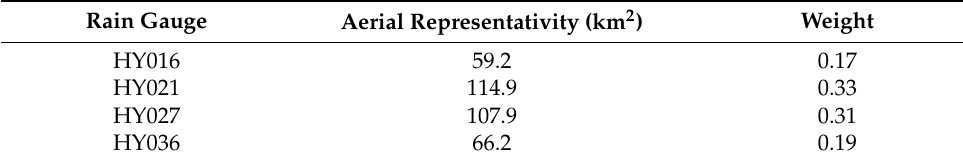
Table 2. Aerial representation and relative weight of each rain